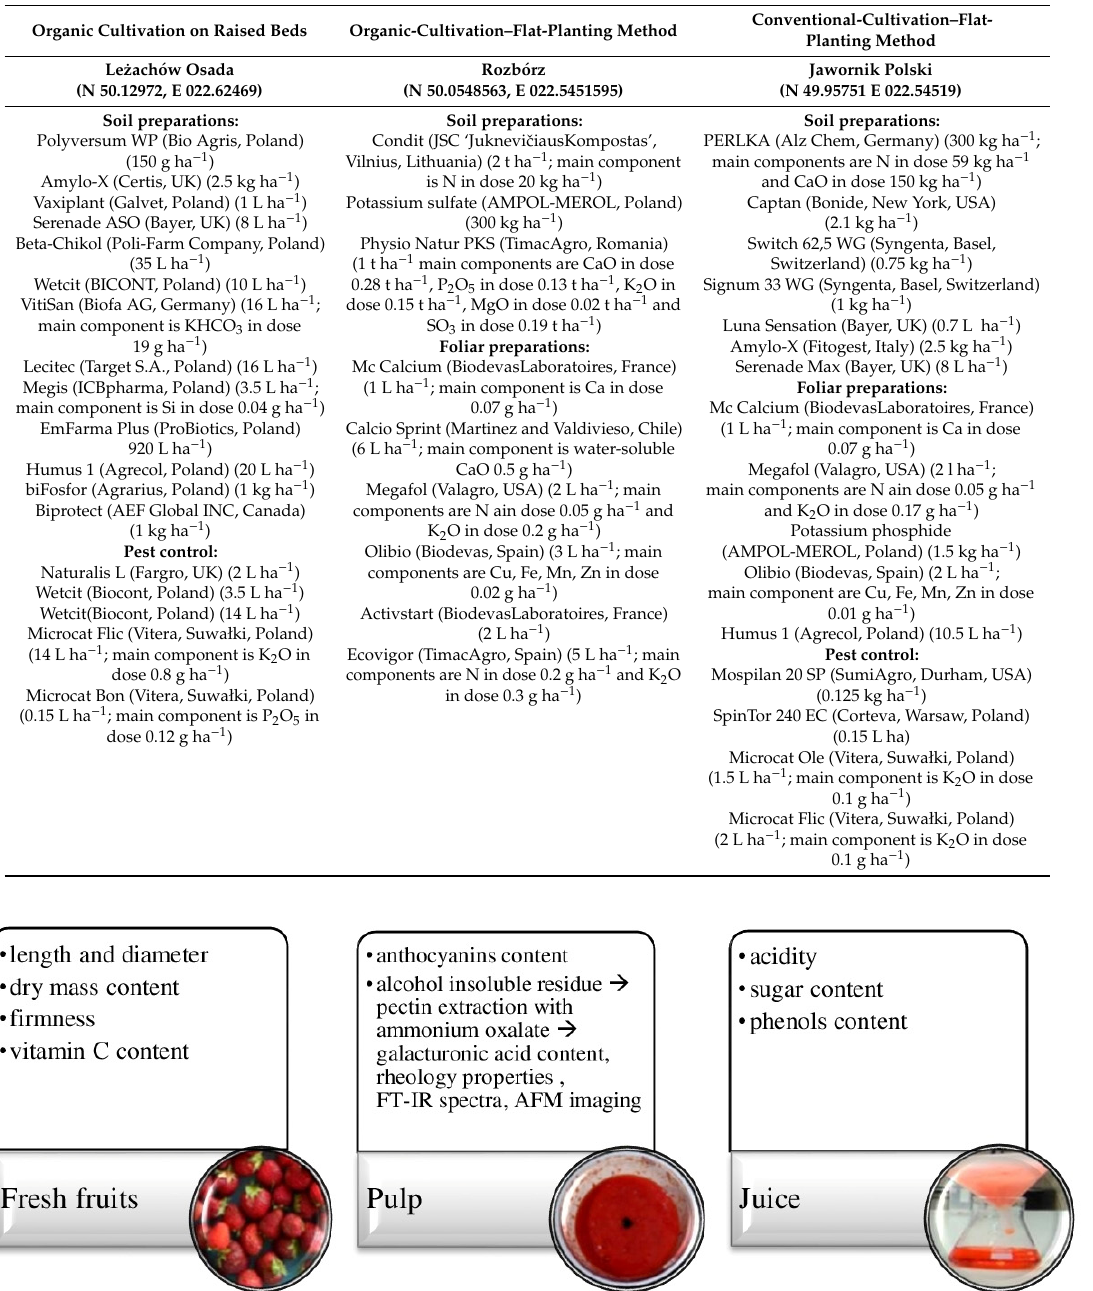
Table 1. Preparations used in the cultivation of strawberries cv. Honeoye.